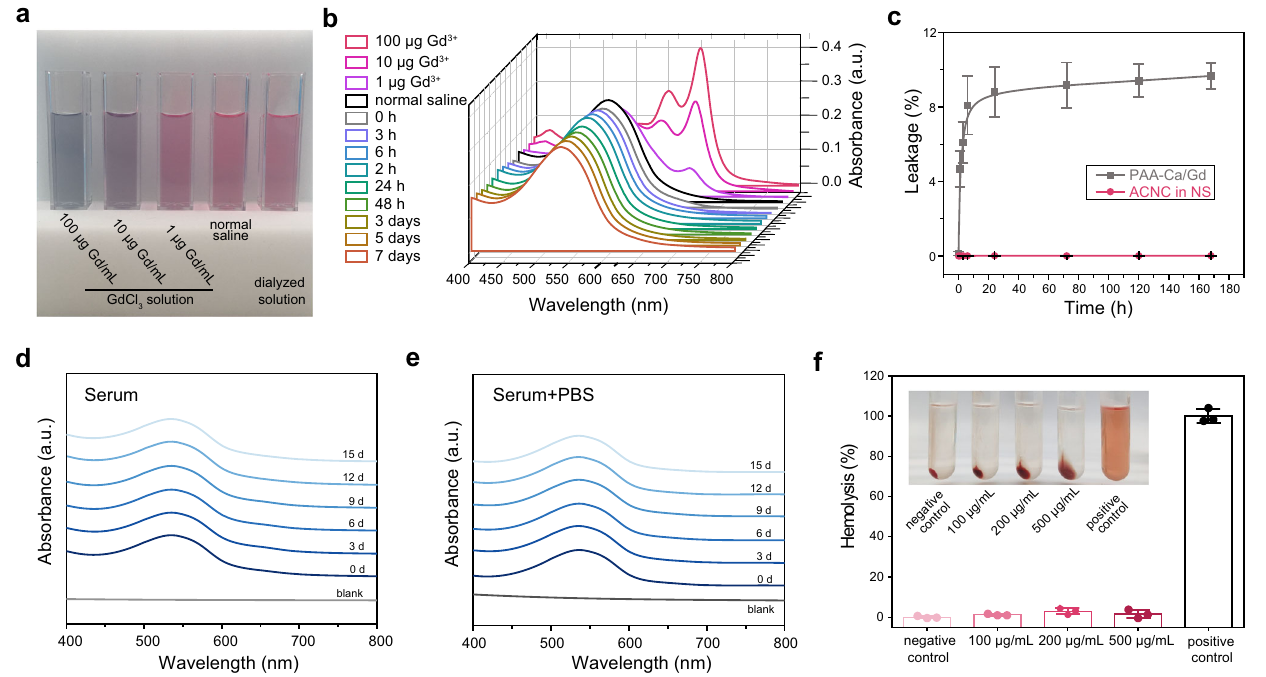
Fig. 4 | Stability study. a Photos of the mixtures of Arsenazo III aqueous solution withdialyzedsolutionsofACNC,normalsaline(NS,servedasnegativecontrol),and gadolinium chloride aqueous solution at varying concentrations (1, 10, and 100 µ g Gd/mL) (served as positive controls), respectively. b Absorption spectra of ArsenazoIII-dialysatemixtures,anddialysateswerecollectedatvaryingtimepoints in 7 days to monitor the leakage of gadolinium from ACNC. No detectable leakage of gadolinium ion was monitored compared with the negative (NS) and positive (gadolinium chloride aqueous solution) controls. c Quantitative analysis and comparisonoftheleakageoffreegadoliniumionfromACNCandPAA-Ca/GdinNS